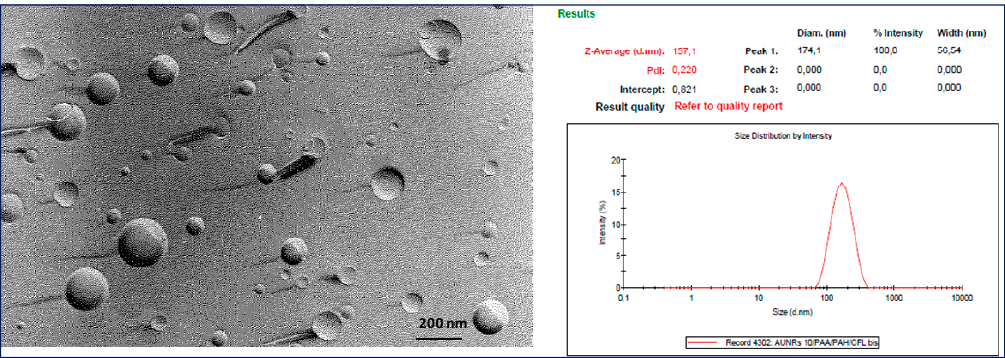
Figure 2. Freeze fracture electron micrograph and size distribution of unfunctionalized DA ∙ HCl-LPs.